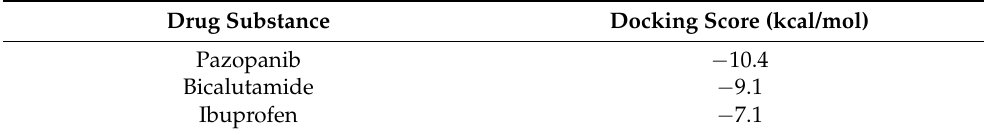
Table 3. Molecular docking scores of receptor-ligand